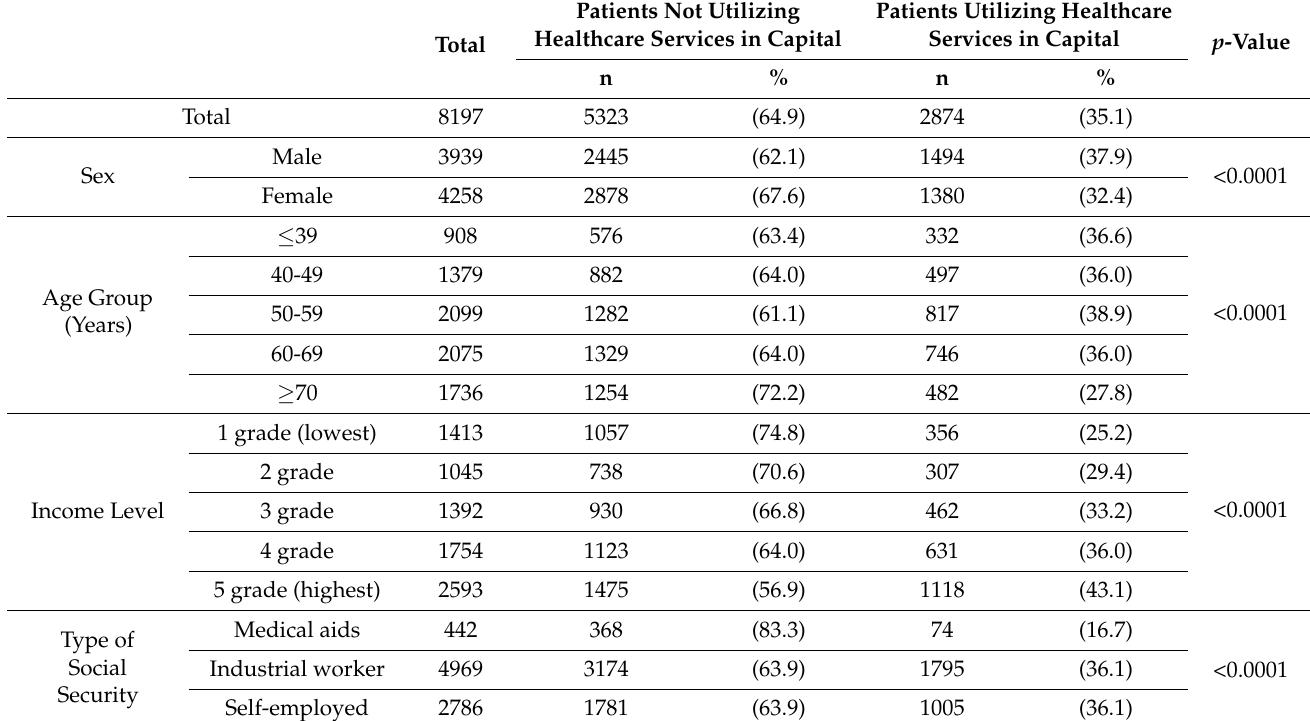
Table 1. Characteristics of the study